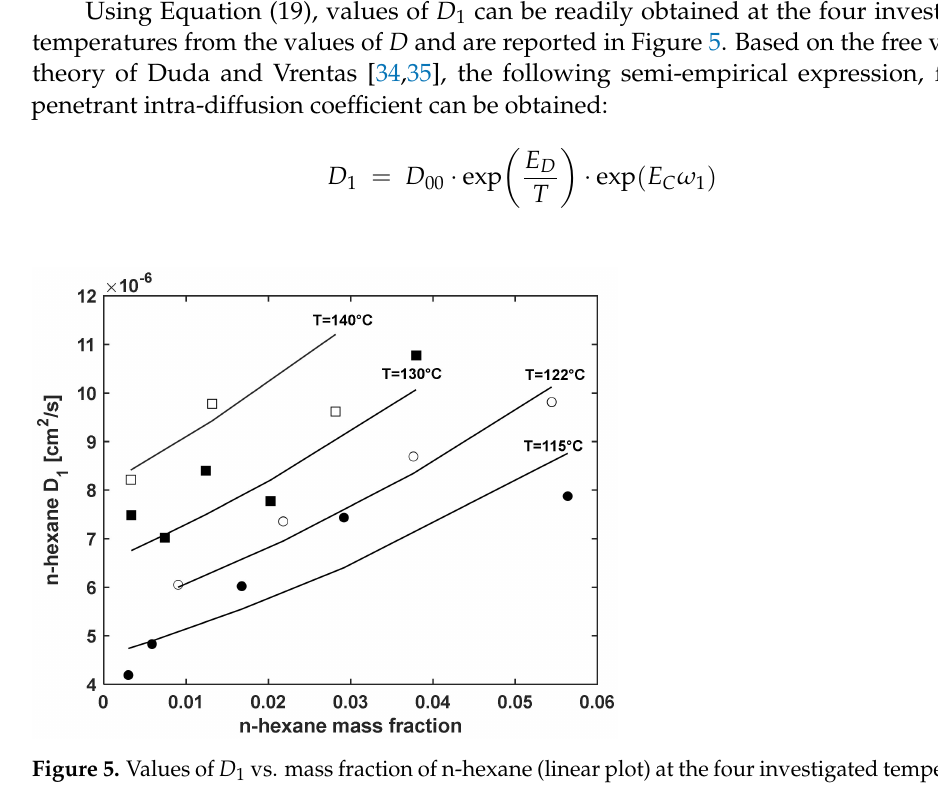
Figure 5. Values of D 1 vs. mass fraction of n-hexane (linear plot) at the four investigated temperatures (115 ◦ C (black circles), 122 ◦ C (white circles), 130 ◦ C (black squares), and 140 ◦ C (white squares)). Continuous lines represent best fitting of data by means of Equation